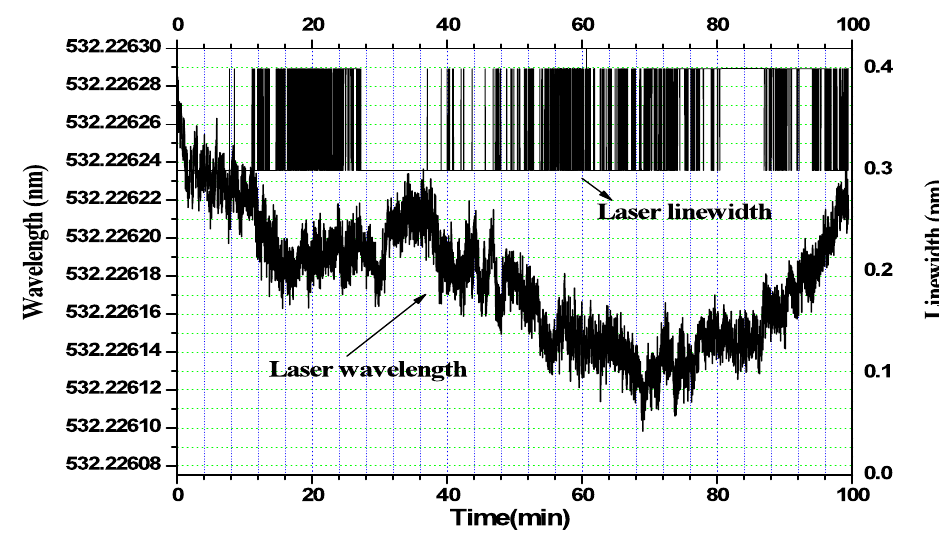
! Figure 1. Frequency stability and line width of the laser, as measured with a wavelength